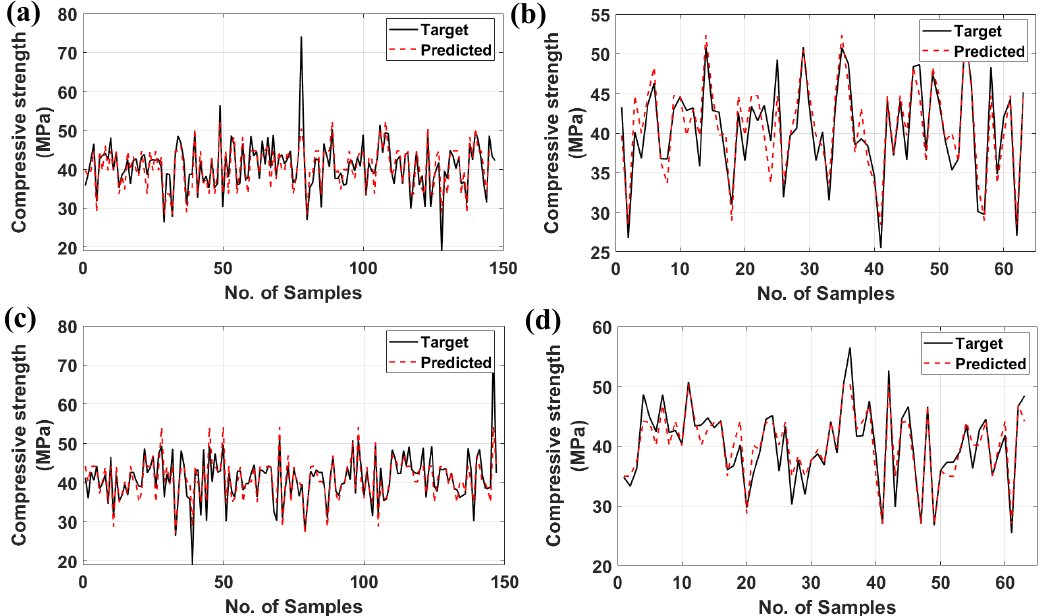
Figure 6. Target and predicted values of compressive strength of different models: ( a ) training ANN, ( b ) testing ANN, ( c ) training ANFIS, and ( d ) testing ANFIS.